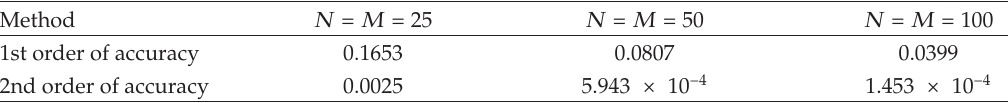
Table 2: Error analysis of first and second order of accuracy di ff erence schemes for Example